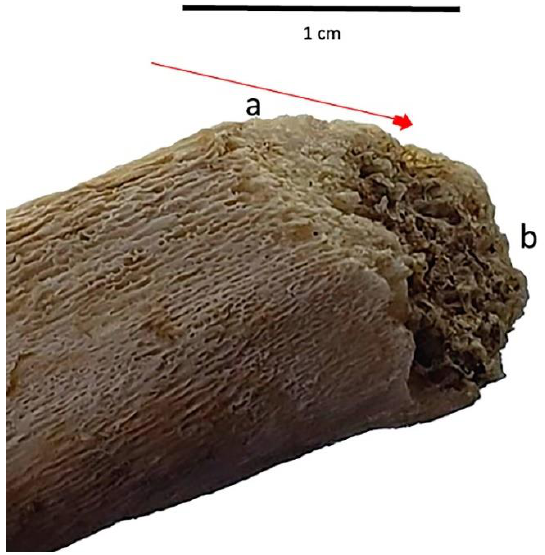
Figure 7. Class 4 experimental chop mark made by the copper axe on a pig rib (cBI 41); (a) beginning of sheared surface, (b) controlled breakage after kerf fracture. The arrow indicates the direction of the chop.